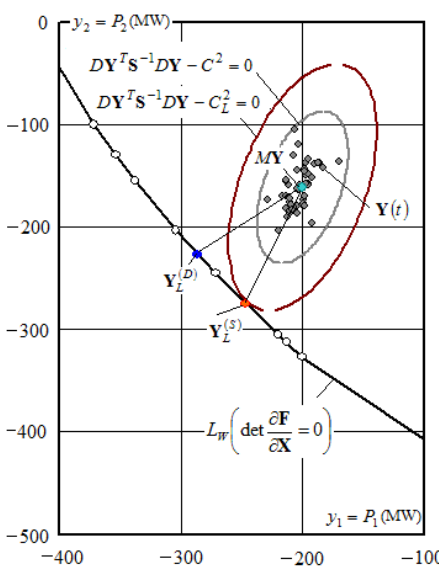
Computation 2022 , 10 , x Figure 4. Results of determining limiting modes in a stochastic statement. Figure 4. Results of determining limiting modes in a stochastic statement.